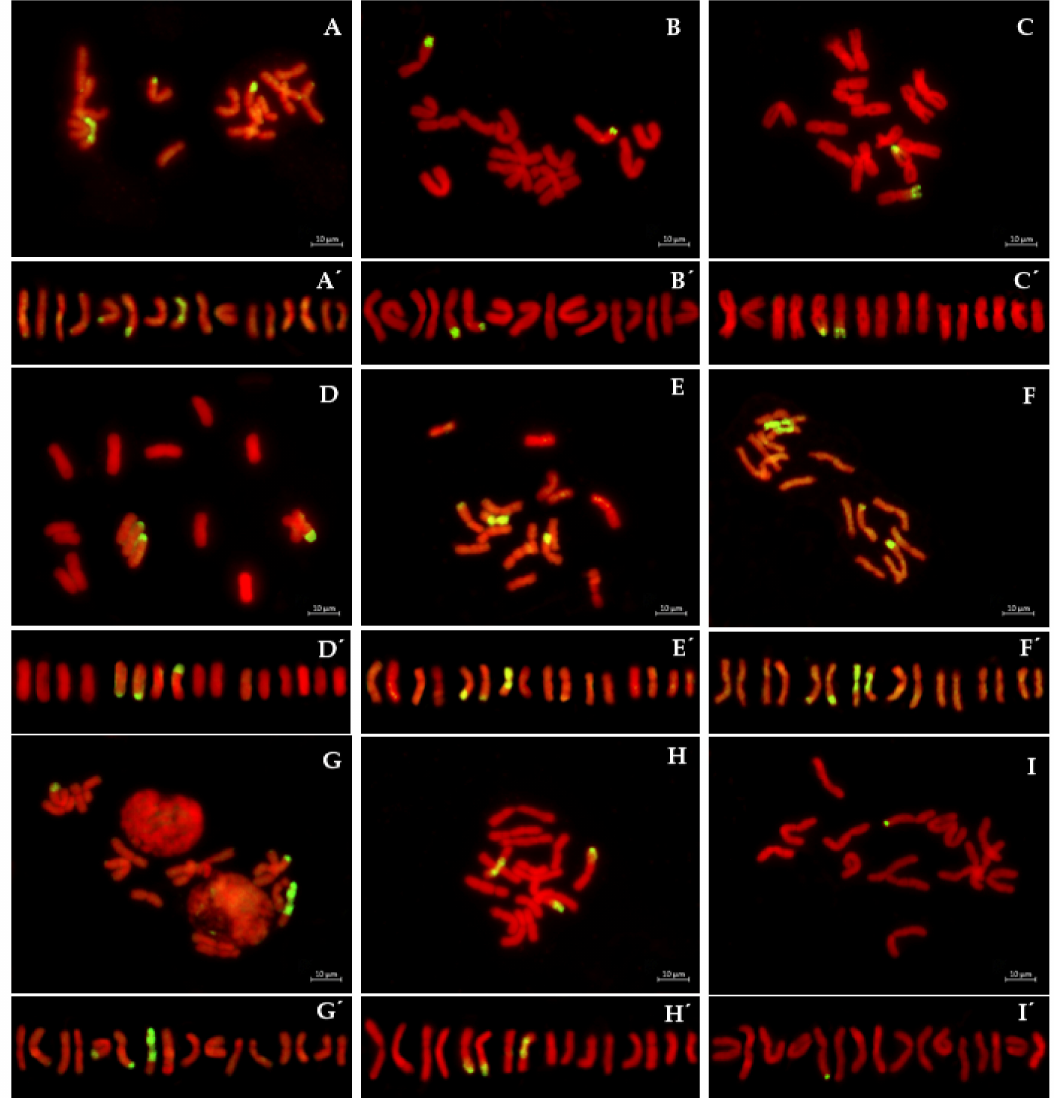
Figure 2. Genomic in situ hybridization (GISH) analysis of S 1 BC 2 and S 2 BC 2 introgression homozygous lines resistant to downy mildew. ( A ) S 1 BC 2 -8. S 2 BC 2 -8: ( B ) 8-33, ( C ) 8-53, ( D ) 8-20, ( E ) 8-32, ( F ) 8-38, ( G ) 8-45 and ( H ) 8-56. ( I ) Santero. ( A’–I’ ) karyotypes of the corresponding accessions. A. roylei genetic material appears in yellow and A. cepa genetic material appears in